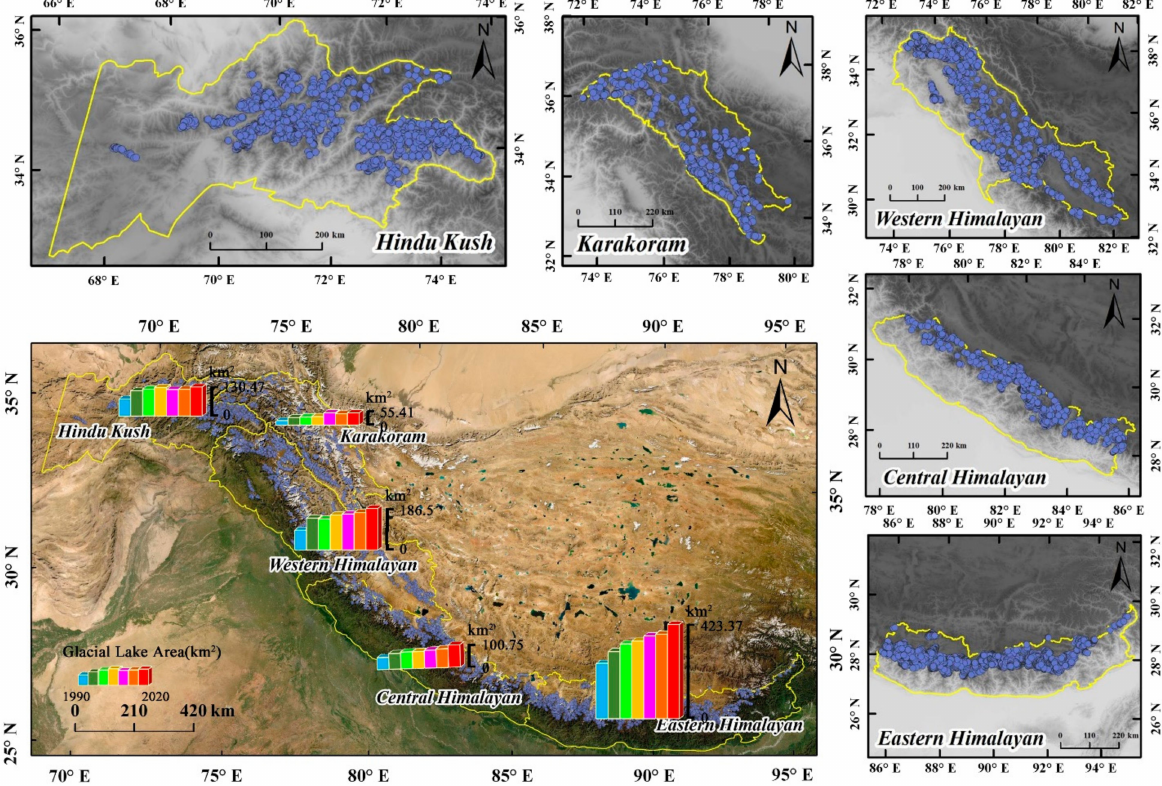
Figure 11. Distribution of glacial lakes in 2020 and area change from 1990 to 2020 in five moun- tain